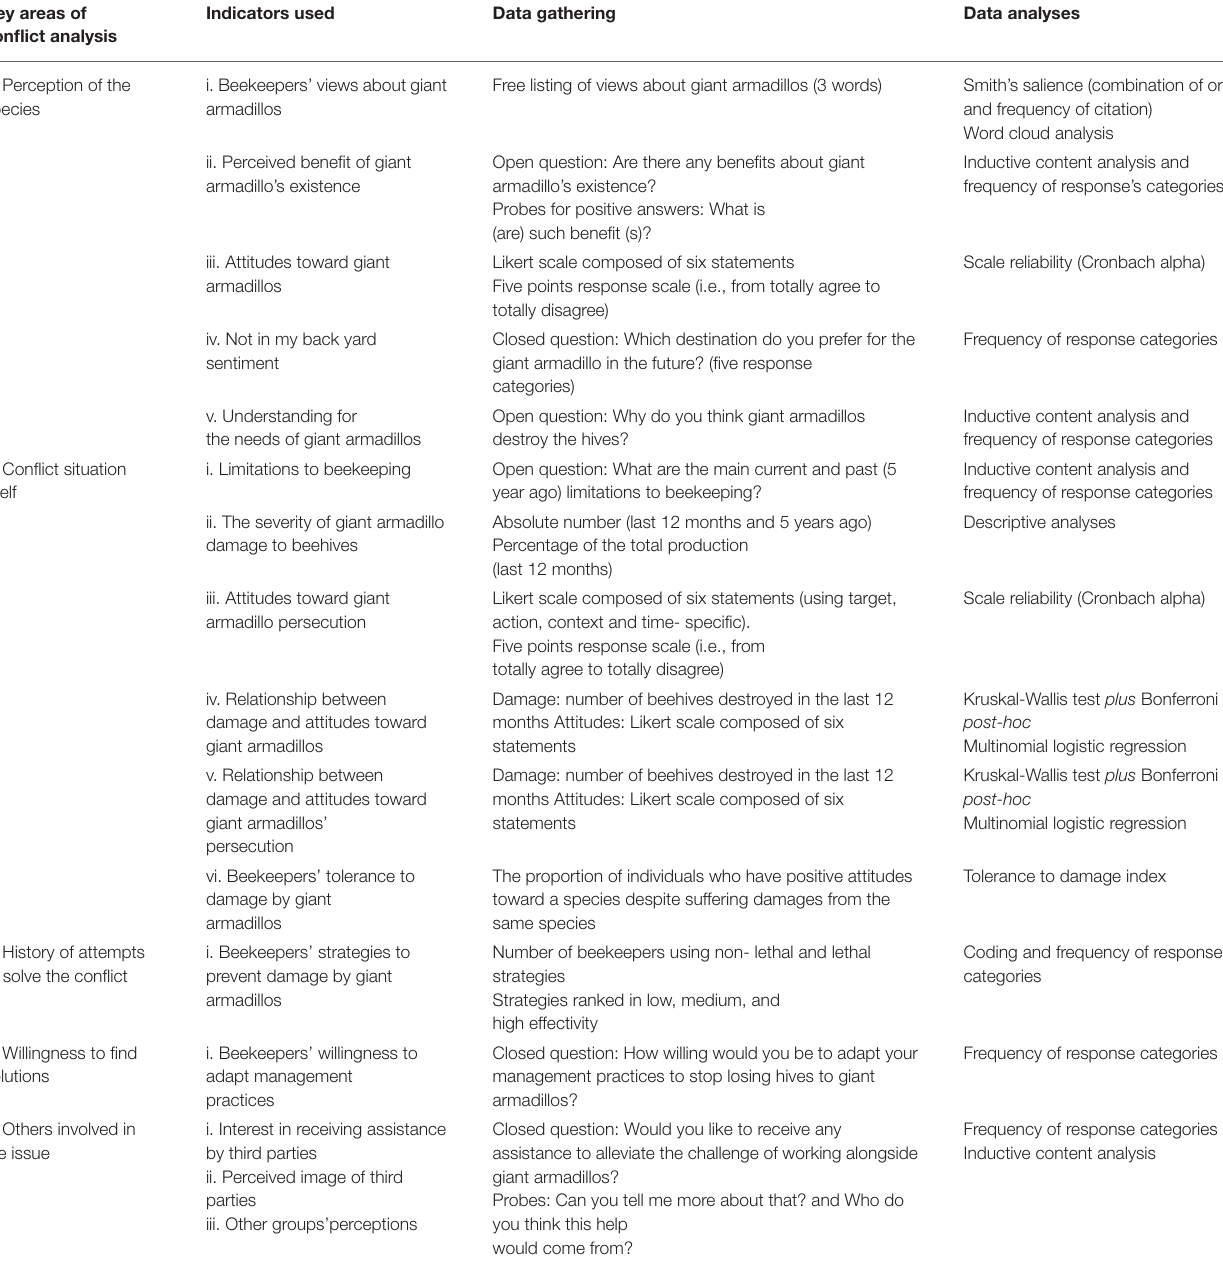
TABLE 1 | Indicators devised to assess each of the five key areas of conflict analysis proposed by Zimmerman et al. (2020), data gathering and analyses. Key areas of conflict